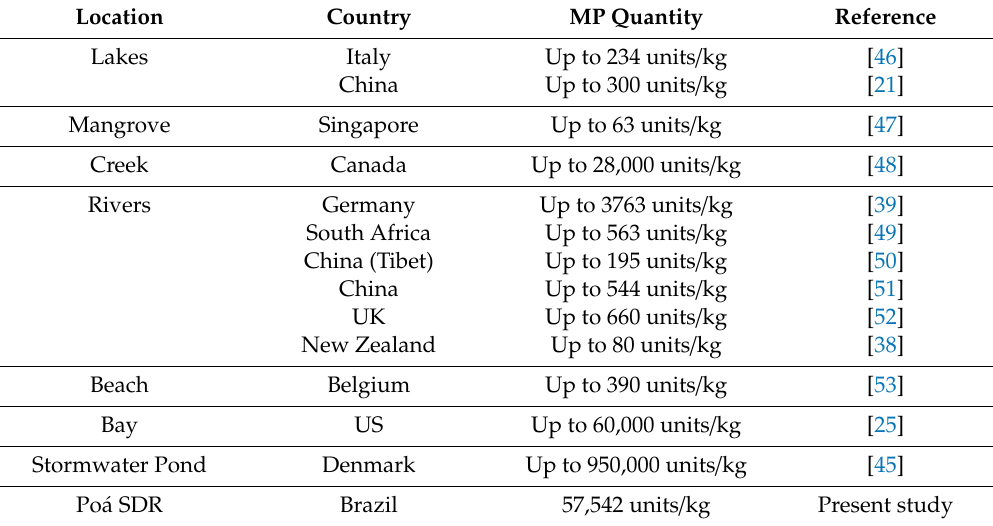
Table 3. Previous studies on MP in